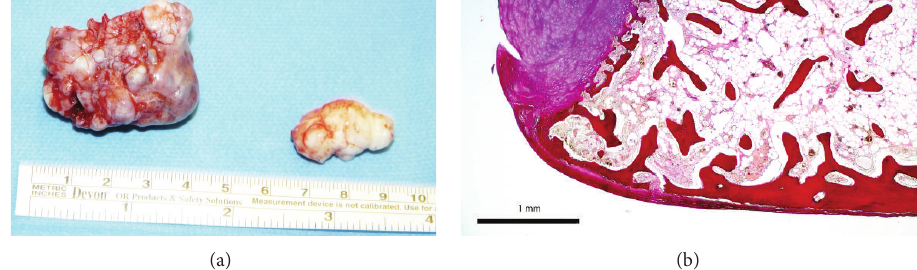
Figure 5: (a) Macroscopical aspect of the 2 masses from the ankle joint. (b) Corresponding microscopical aspect (Van Gieson’s stain, magnification